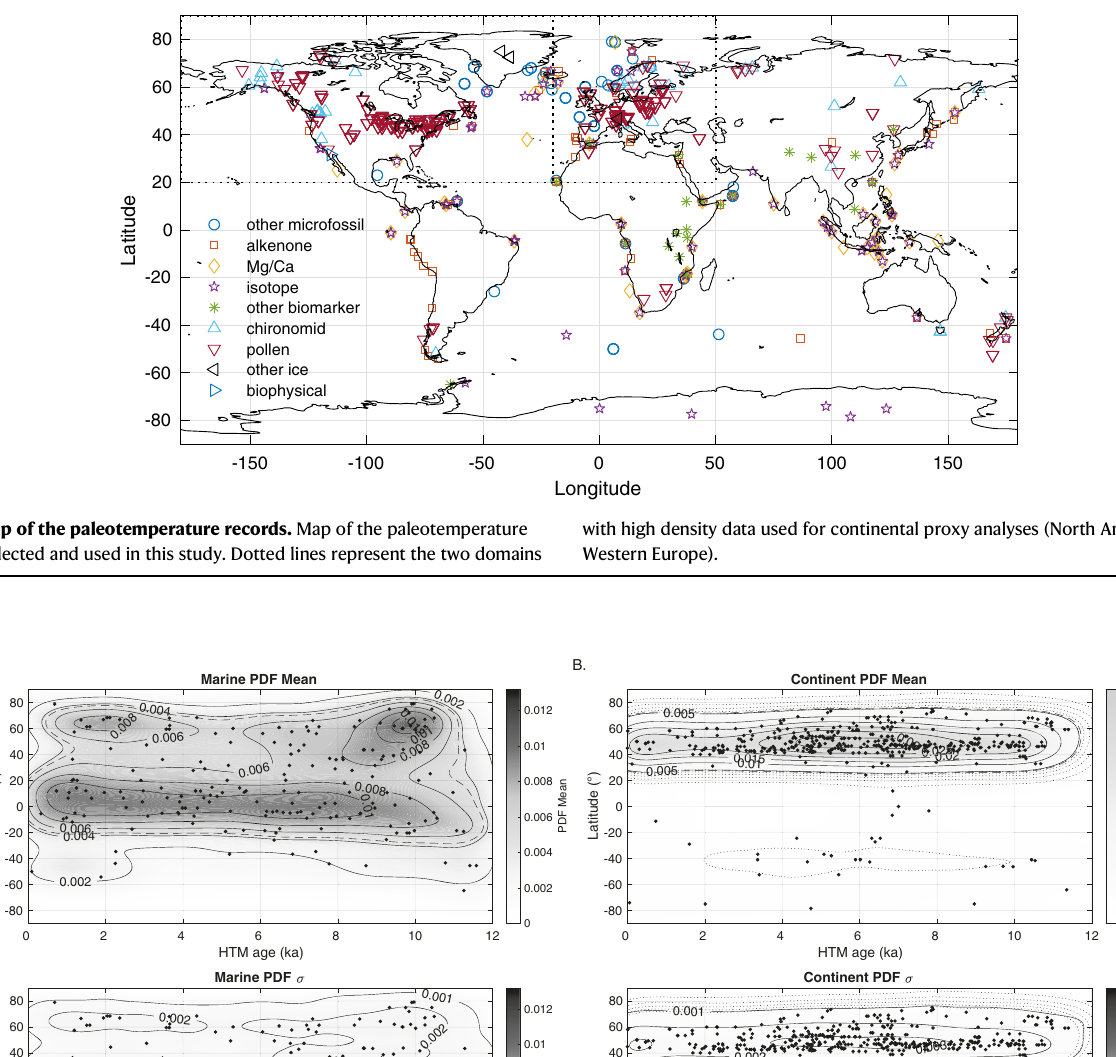
standard deviation ( σ ), and standard deviation (% of local PDF), of the 10,000 PDF maps calculated using ages and temperature ensemble in Temp12k